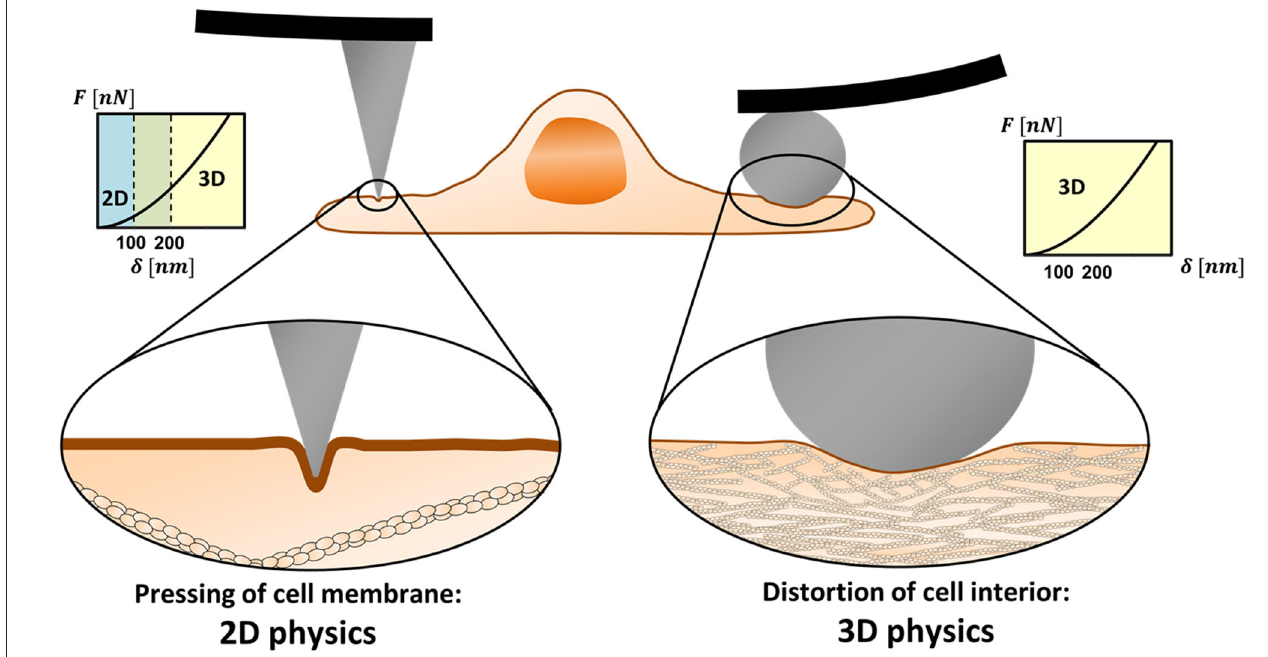
FIGURE 1 | 2D vs. 3D physics in mechanical measurements of cells using AFM. Sharp nanoprobes can squeeze the cell membrane in between the actomyosin cortex filaments ( left ). In low to medium range of indentation depths (typically ≤ 100nm), other cell components may not be affected by the tip load. Then, the membrane resistance to the load needs to be represented by 2D physics rather than by 3D (contact mechanics) theories. When a microprobe is used, the load diameter is larger than the cortex mesh and the system obeys 3D physics even for relatively shallow indentations ( right ).